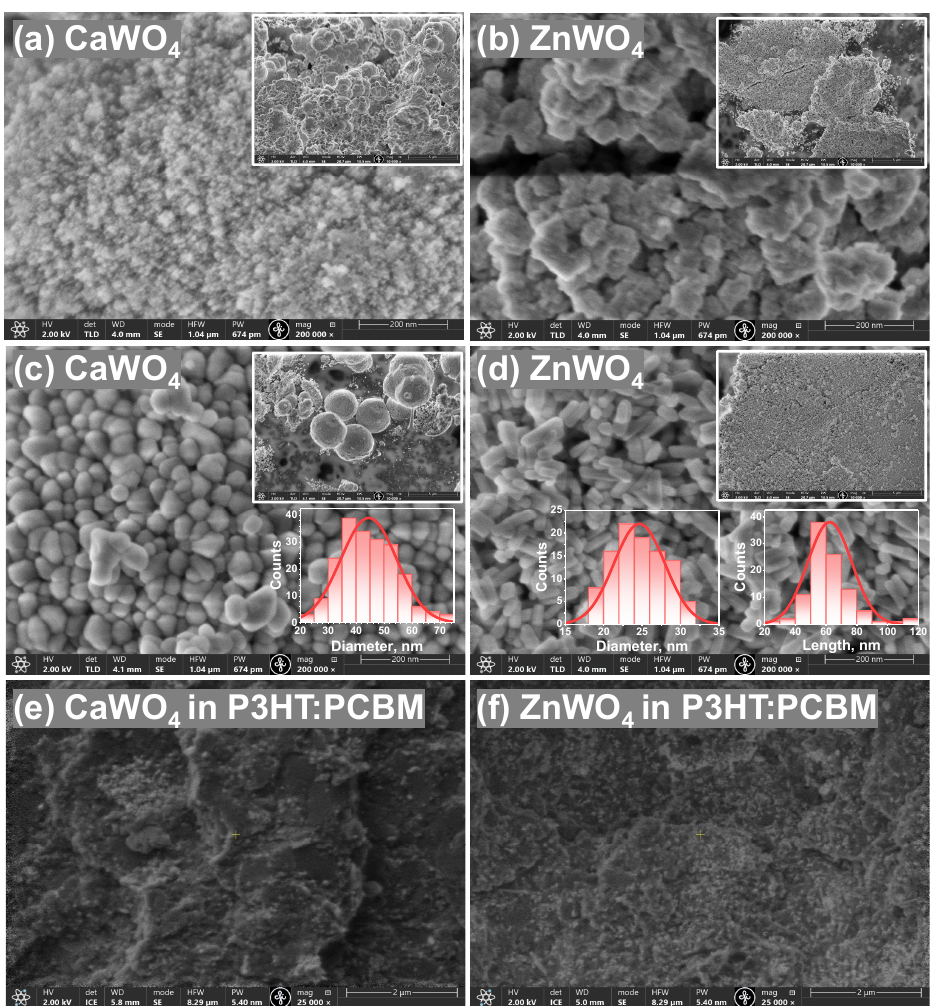
Figure 3. SEM micrographs of CaWO 4 and ZnWO 4 nanoparticles at RT ( a , b ) and treated at ∼ 160 °C for 24 h ( c , d ). Cross-section SEM images of fabricated hybrid detectors (part of tungstate NPs incorporated in a P3HT:PCBM matrix) are also shown in ( e , f ). The particle-size distributions of CaWO 4 (diameter of nanoparticles) and ZnWO 4 (diameter and length of nanorods) estimated from the corresponding SEM micrographs are shown in the insets in ( c , d ),